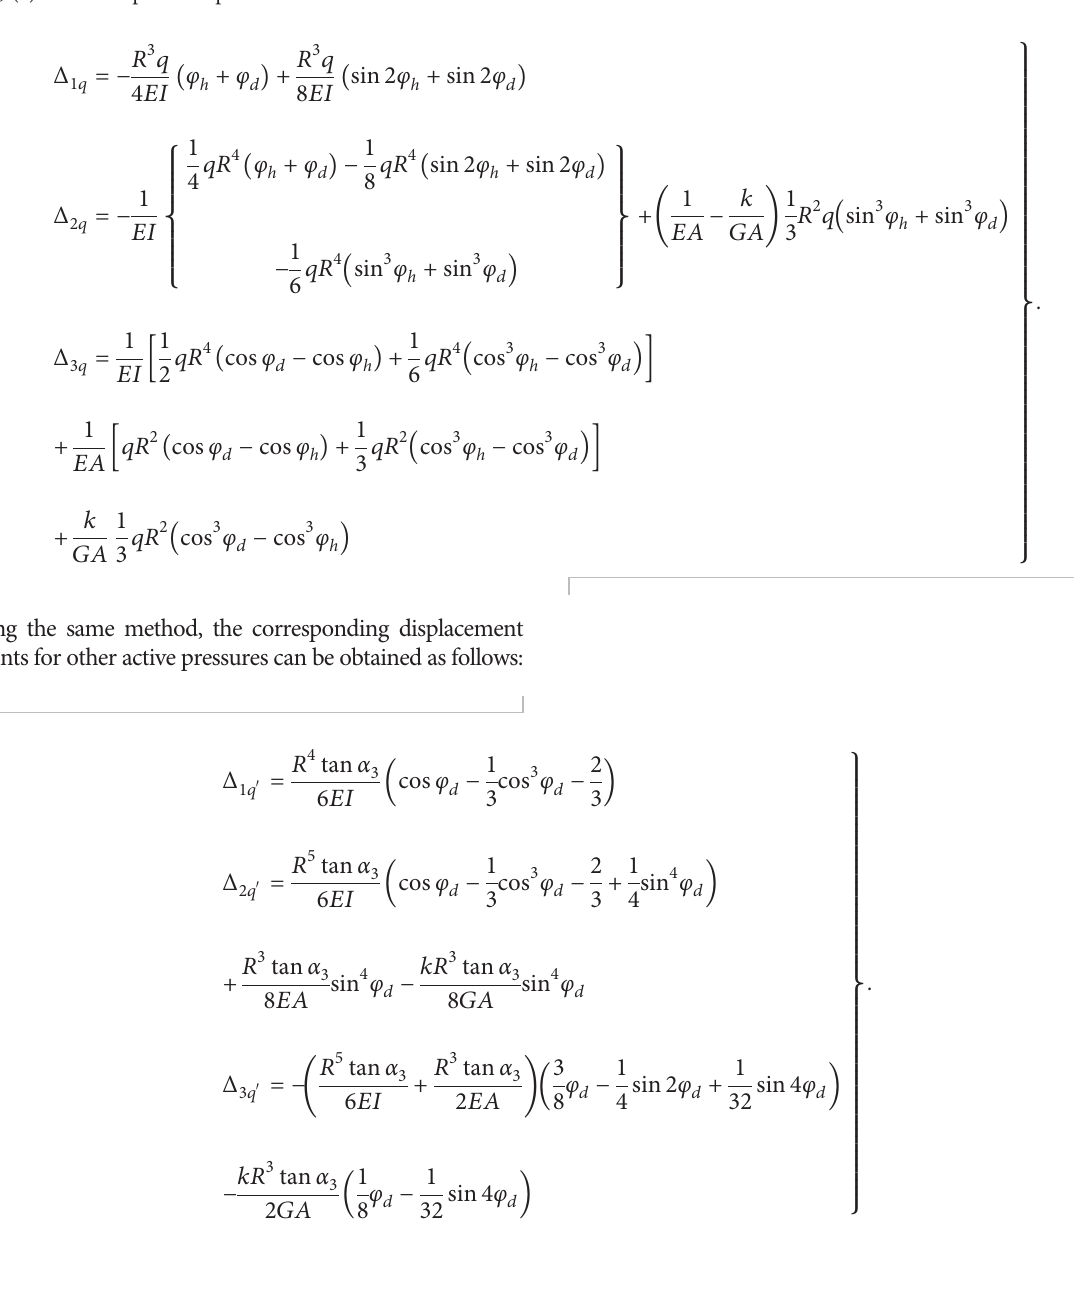
Figure 4: The force analysis diagrams of the basic structure of the arch ring under (a) vertical uniform pressure; (b) vertical triangular pressure; (c) lateral trapezoidal